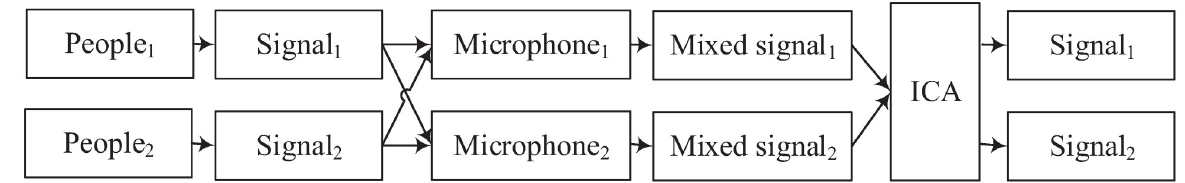
Fig 3. An example of the process of extracting signals from the cocktail party problem with two speaking people (source signals) and two microphones (mixture signals).